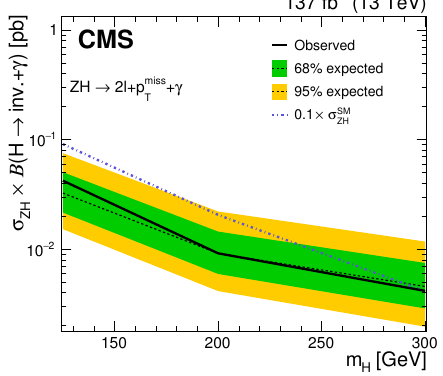
Figure 4 . Expected and observed upper limits at 95% CL on the product of (cid:27) invisible + (cid:13) ) as a function of m . The dot-dashed line shows the predicted signal corresponding H to 0 : 1 (cid:27) ZH